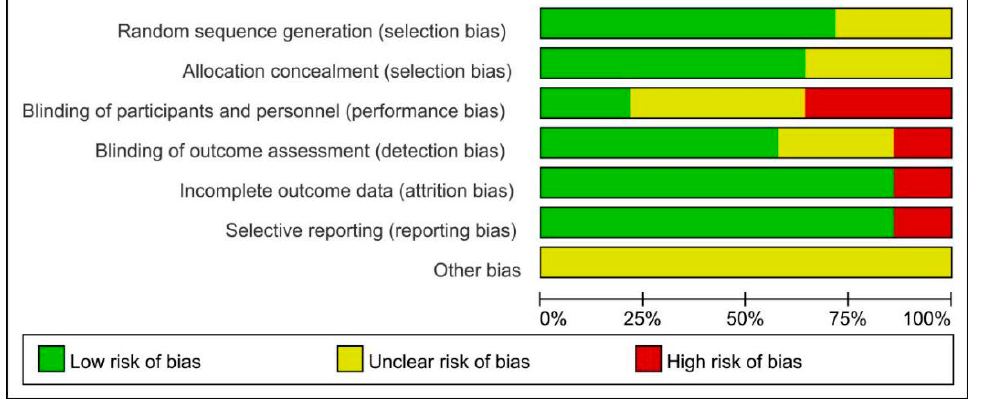
Figure 2. Risk of bias graph.